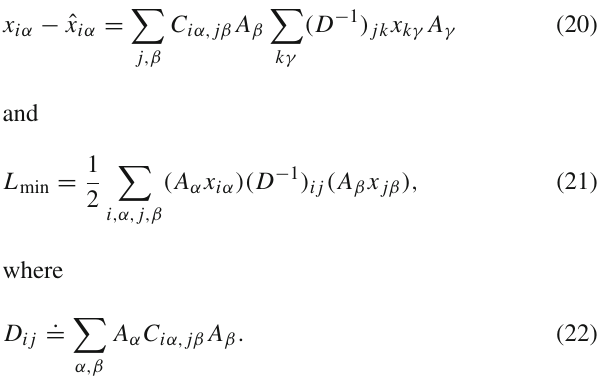
Table 1 Results for am S Z − 1 from the previous method and from the generalised least squares (GLS) method for our ensembles at β = 5 .